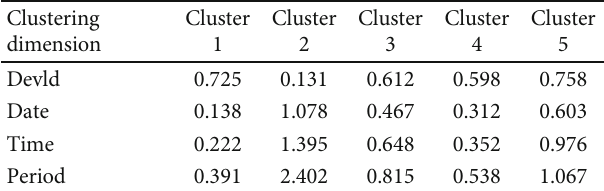
Table 5: KL divergence value when k is taken as 5.